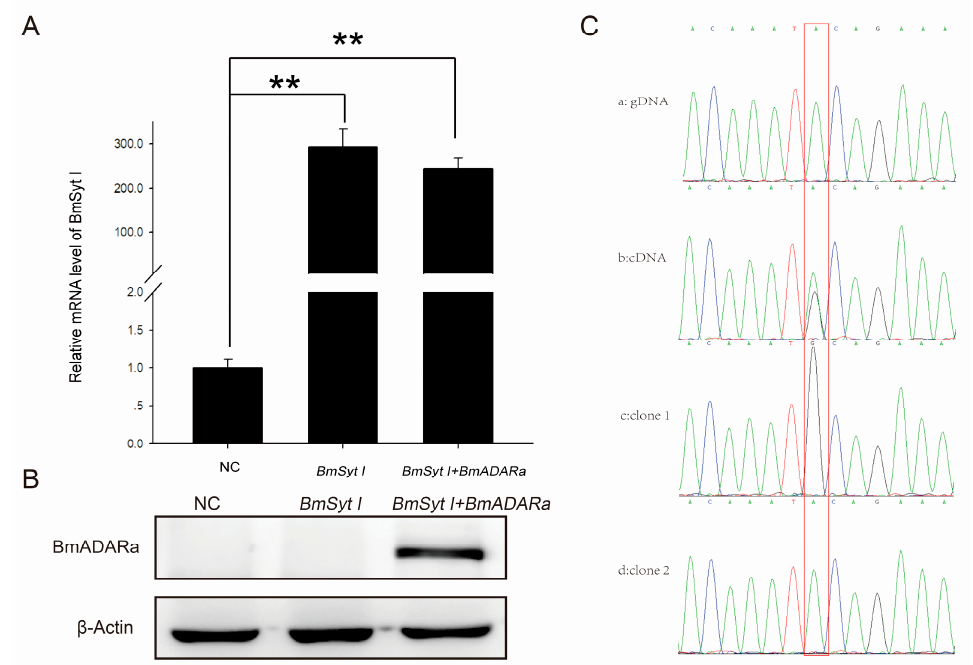
Figure 5. Identification of the A-to-I RNA editing function of BmADARa on BmSyt I in the BmN cells. ( A ) qRT-PCR analysis of BmSyt I transcriptional level after BmSyt I-pIZ-EGFP transfection or co-transfected with BmADARa-pIZ-EGFP. Bmrp49 was used as an internal control. Bars represent the mean ± SEM (n = 3) of at least three independent experiments performed in triplicate. The asterisk represents a significant difference (two-way ANOVA, followed by Tukey’s test as post hoc, ** p ≤ 0.01). ( B ) Western blot analysis after BmSyt I-pIZ-EGFP transfection or co-transfected with